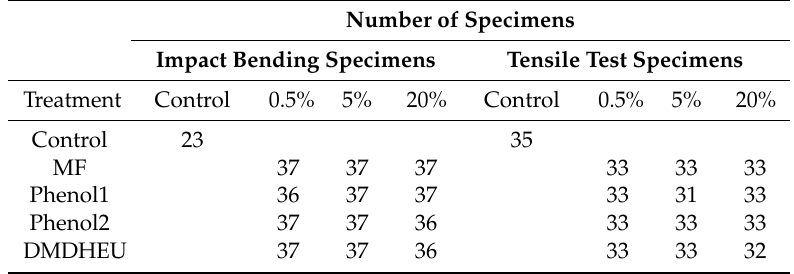
Table 3. Number of specimens depending on the modification agent and concentration. Number of Specimens Impact Bending Specimens Tensile Test